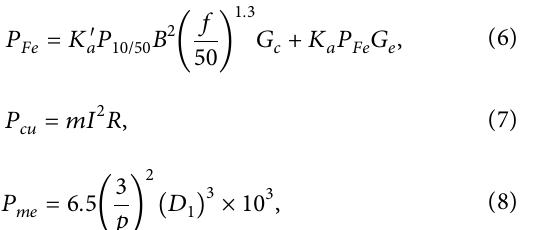
Figure 3: Bearing load due to vehicle